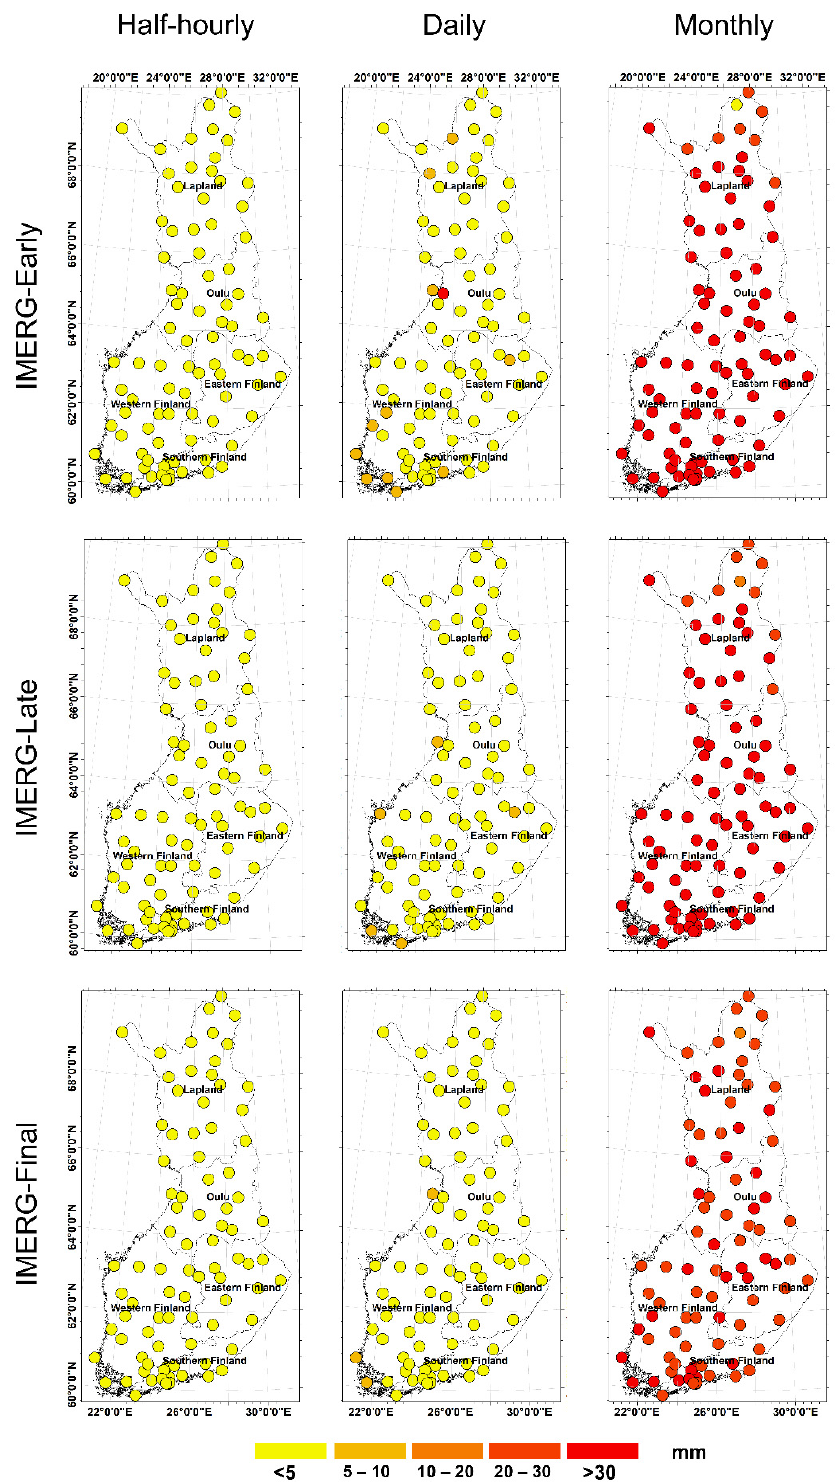
Figure 14. Spatial distributions of the half-hourly, daily, and monthly RMSE for IMERG-Early, IMERG-Late, and IMERG-Final.